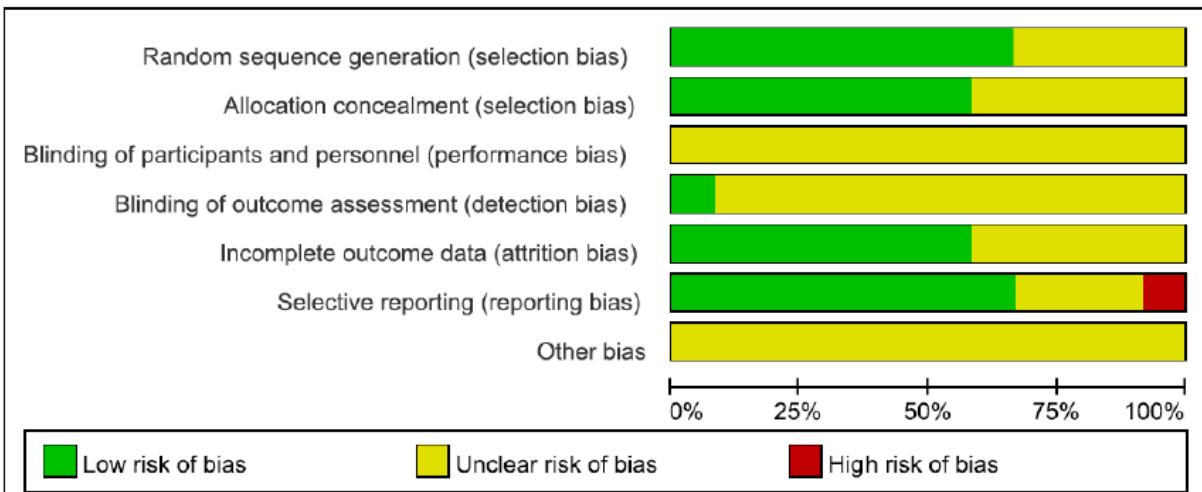
Figure 3. Check for funnel plot. 3.3. Primary Outcome Analysis As a result of a meta-analysis of the 12 studies to determine the reduction in HbA1c in the intervention group using digital healthcare technology, the intervention group showed a statistically significant reduction in HbA1c, compared with the comparison group (SMD: − 0.49 [95% CI: − 0.64, − 0.33], I 2 = 48%, p < 0.00001) (Figure 4).